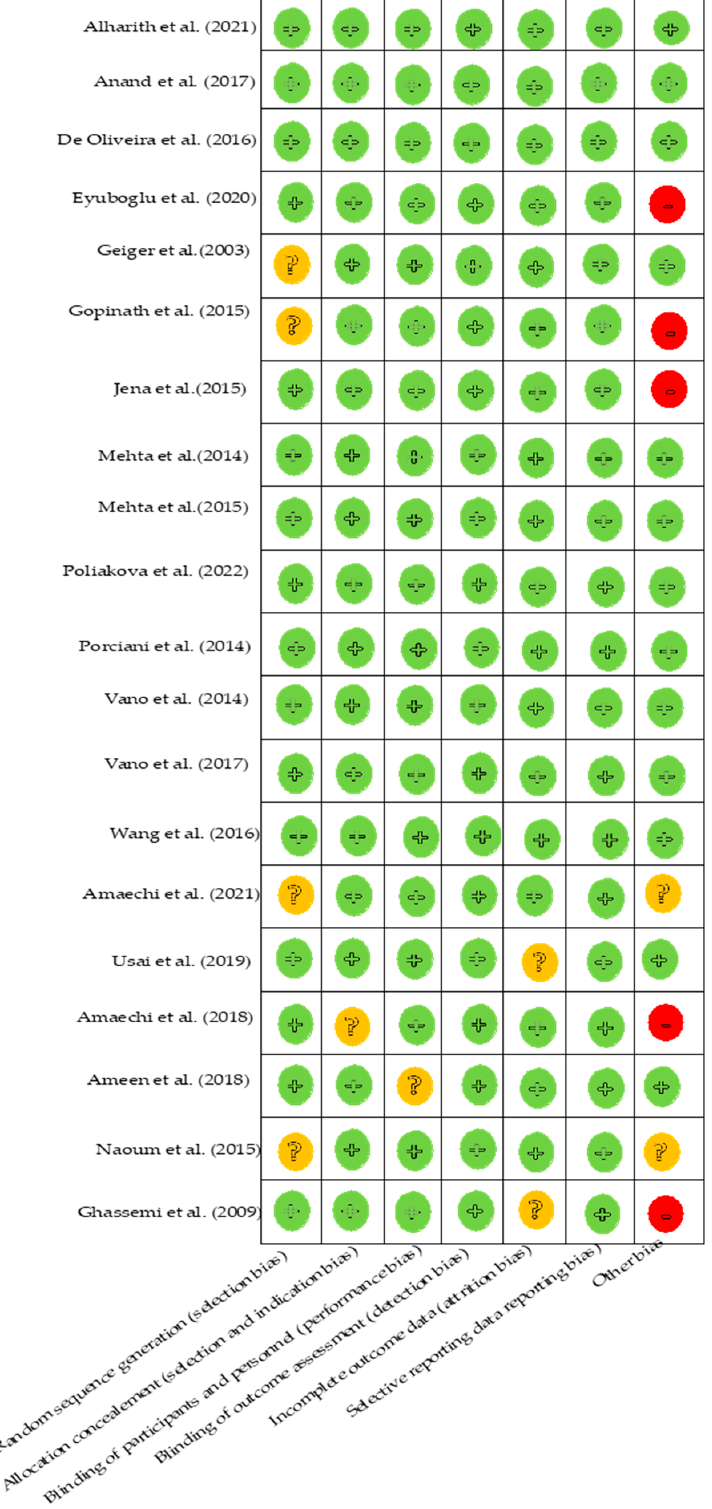
Figure 2. Risk of bias of included studies green indicates low riskof bias [30,31,37–40,43,45–47], orange indicates uncertain or moderate risk of bias [32,34,36,44,49], and red indicates high risk of bias [33,35,41,42,48].